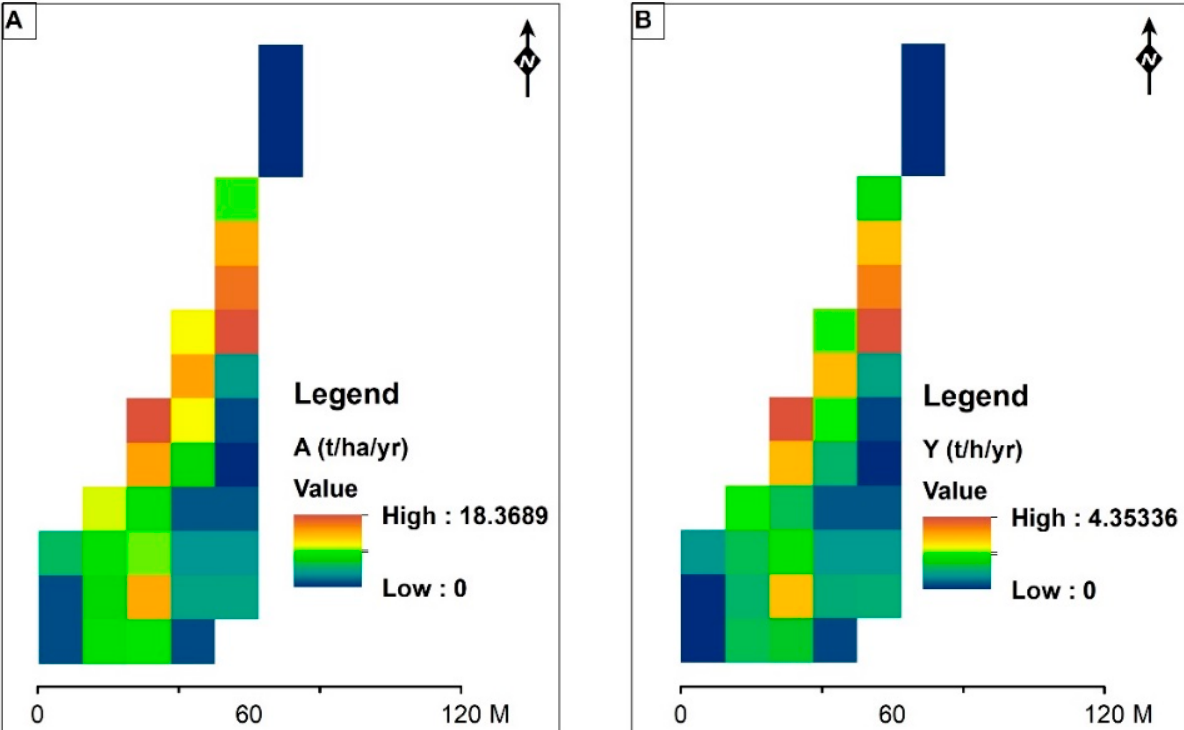
Figure 8. Annual soil loss ( A ) and sediment yield ( B ) in the catchment contributing overland sediment inflow to the main canal of the Arata-Chufa irrigation scheme.